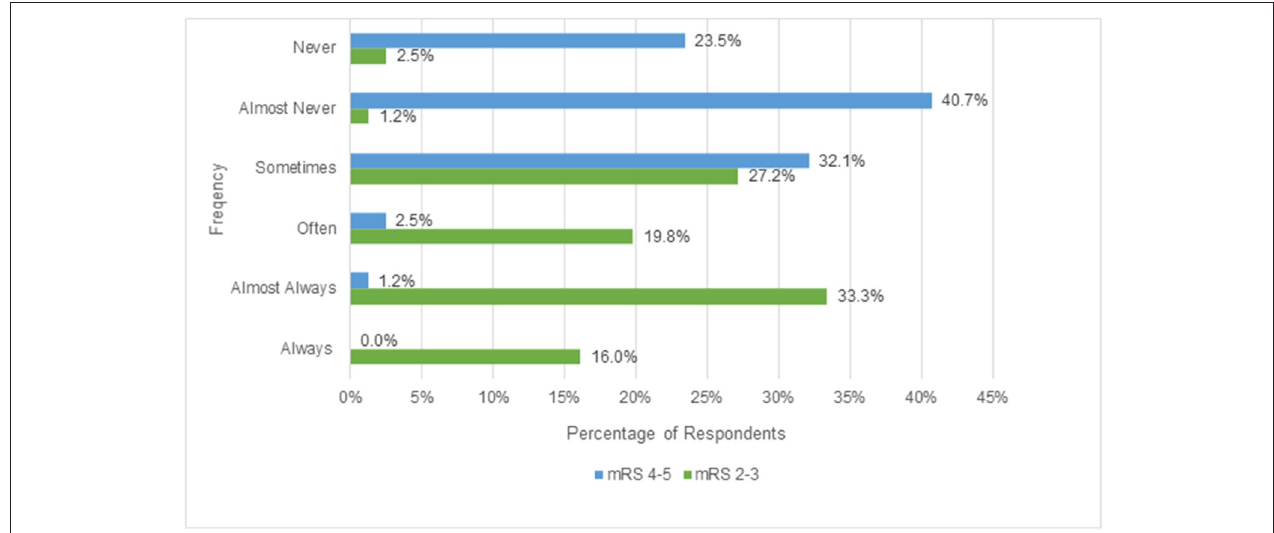
FIGURE 1 | Physician likelihood of considering EVT for patients with pre-stroke disability of mRS 2-3 vs. 4-5.